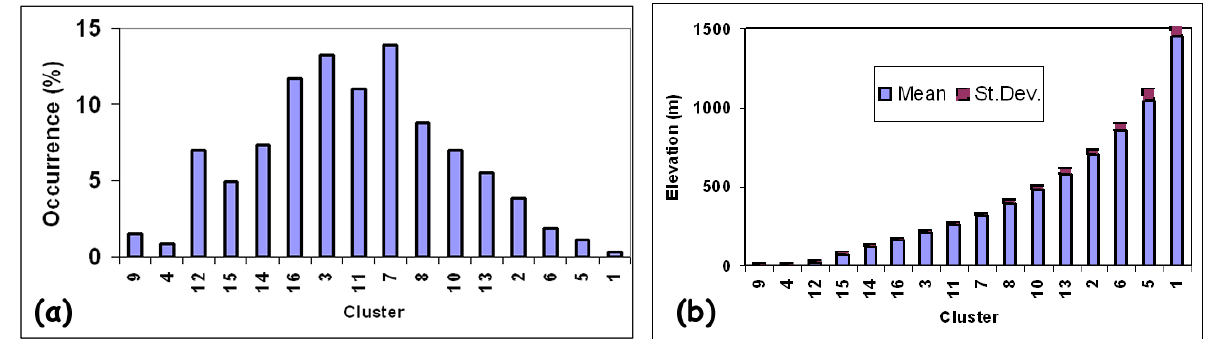
Figure 9. (a) Percent area of each cluster class. (b) Mean elevation within each cluster class. Clusters were sorted in increasing mean elevation (Table 2).